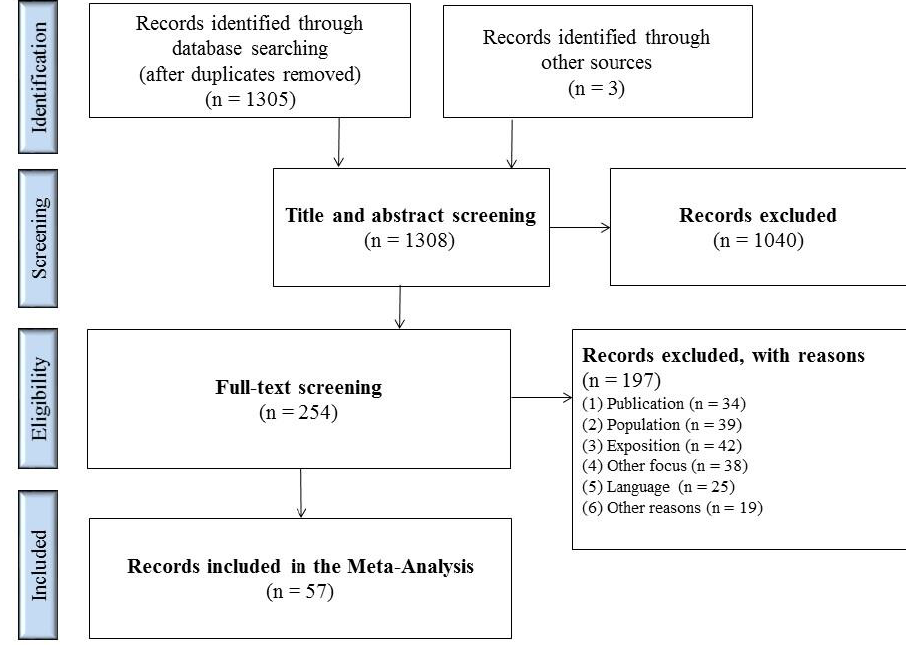
Figure 1. Flowchart of study selection process.